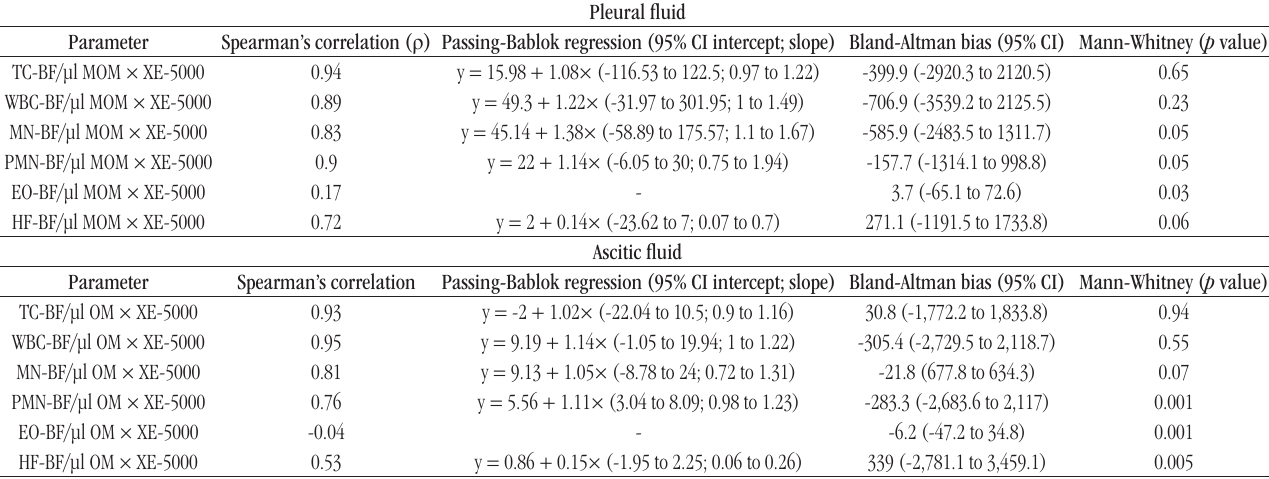
statistical correlation ( ρ = 0.17). Except for EO-BF, for the other parameters the equation coefficients were statistically valid, and the Mann-Whitney U test did not show statistical differences in comparisons, since p values were ≥ 0.05 (Table 3). Positive proportional biases were observed for TC-BF, WBC-BF, MN-BF and PMN-BF of 8%, 22%, 38% and 14%, respectively. HF-BF showed a taBLE 3 − Spearman’s correlation, Passing-Bablok regression, Bland-Altman bias and Mann-Whitney U test for different parameters in XE-5000 × MOM in pleural and peritoneal fluids Pleural fluid